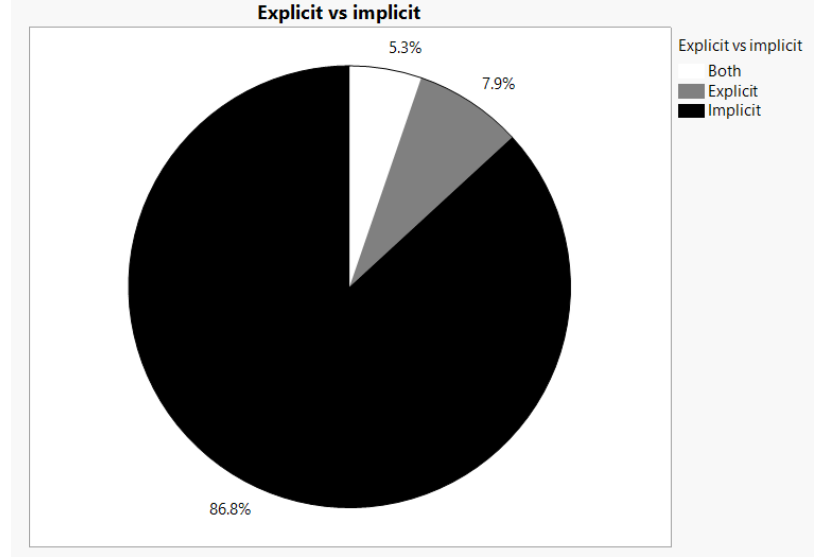
Figure 5. Comparison of explicit vs. implicit AFEA methodologies observed across the 38 studies related to AFEA, beverages, and/or packaging.